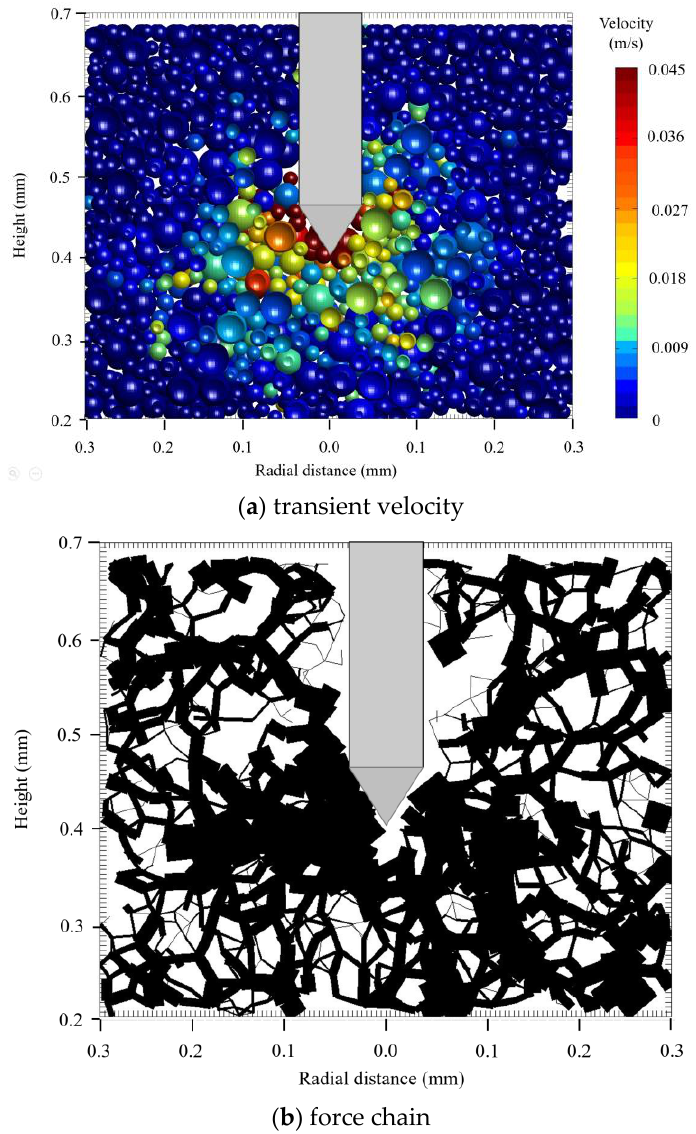
Figure 11. Displacement of particles around the cone ( d c / d 50 = 3.45; maximum: 0.037 m). Table 3. Speedups of CPU and GPU parallel simulations in cone penetration test cases (10,000 in- cremental steps).